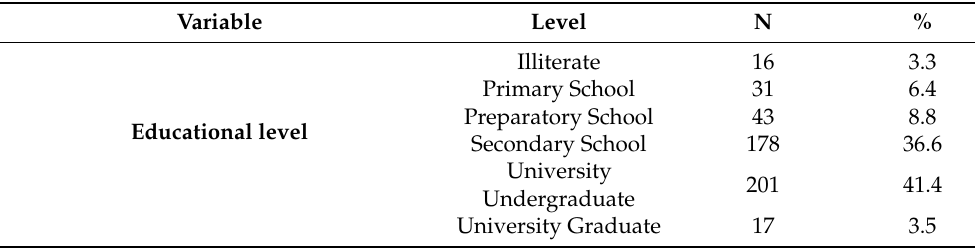
Table 1. Characteristics of the study sample (N = 497). SD = standard